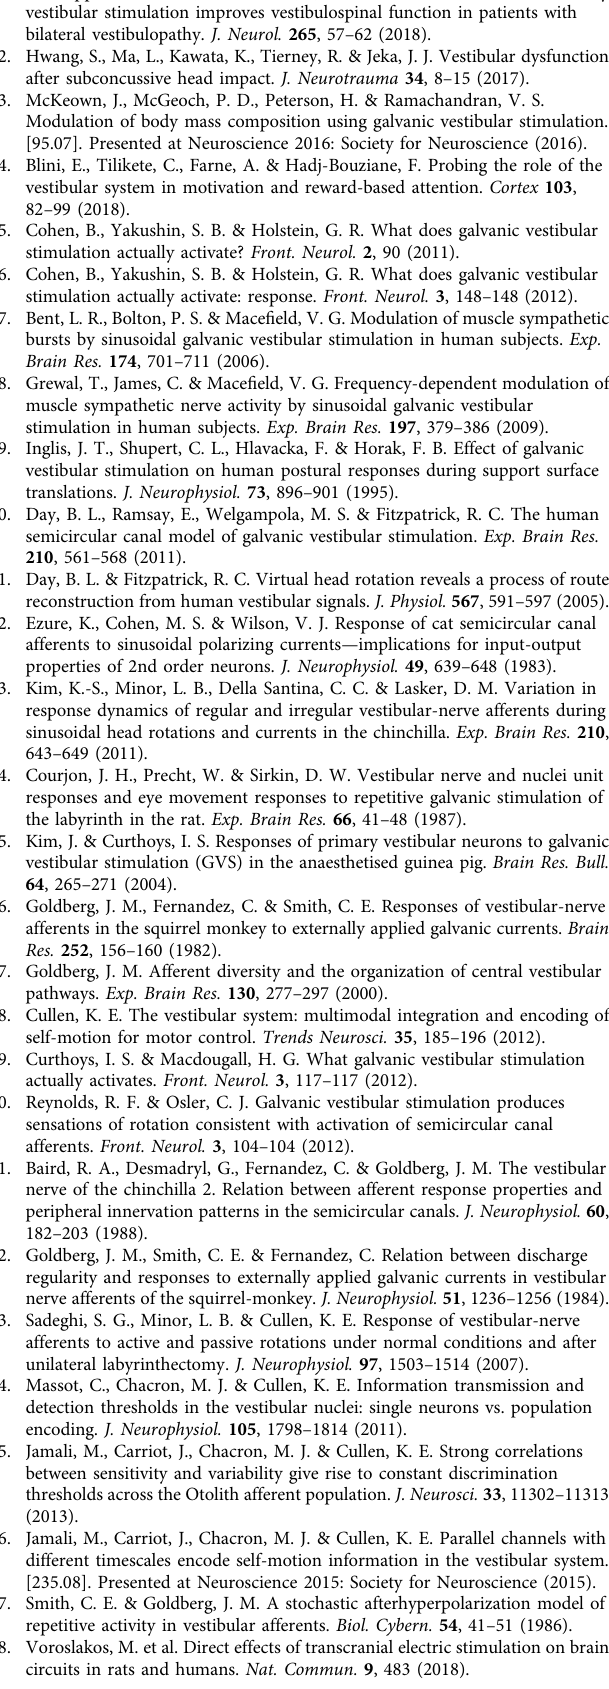
are expressed as mean ±s.e.m. unless otherwise speci fi ed. The detailed results of the statistical comparisons are listed in the Supplementary Table